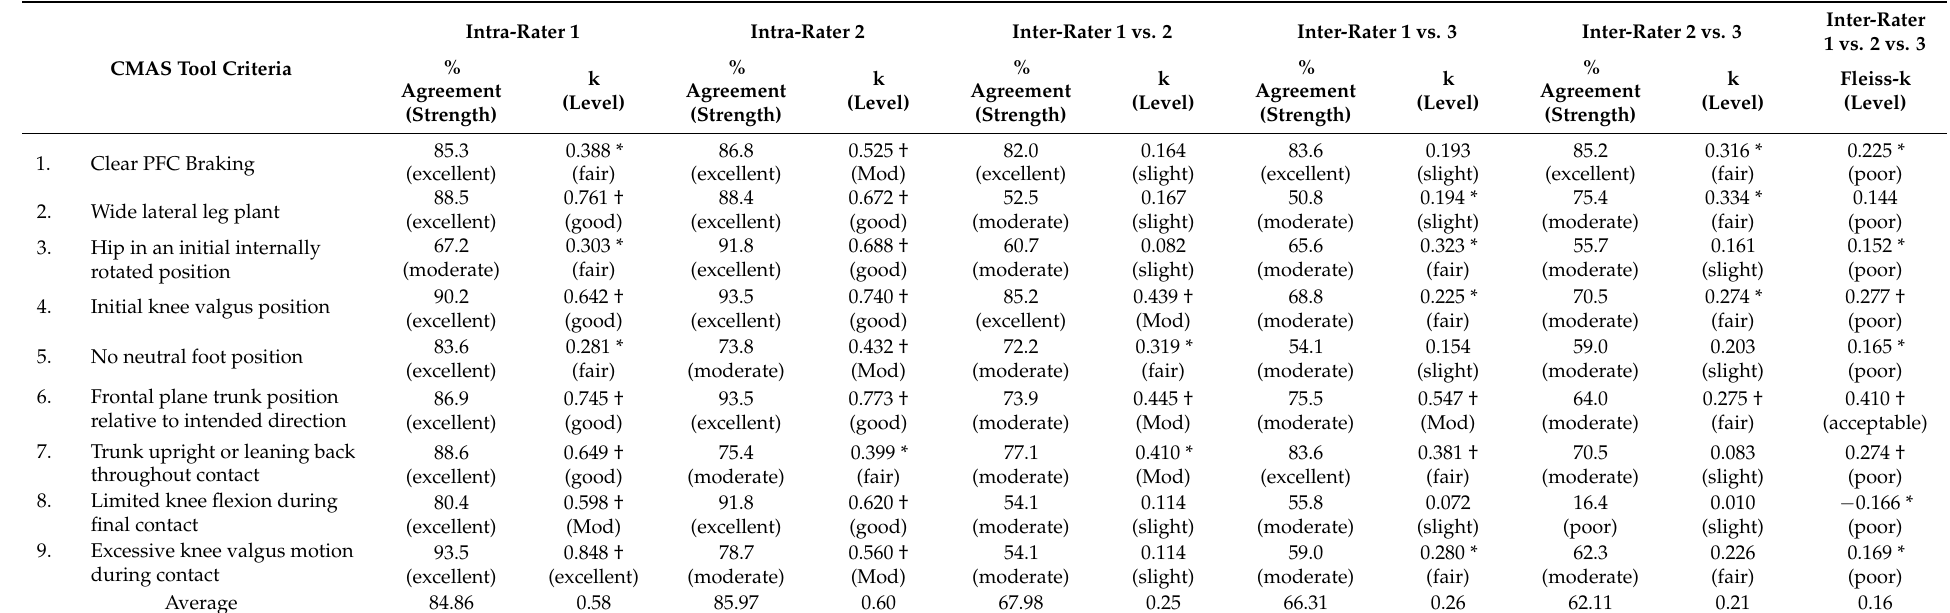
Table 3. Intra-rater and inter-rater reliability of CMAS tool criteria ( n = 61 cases).